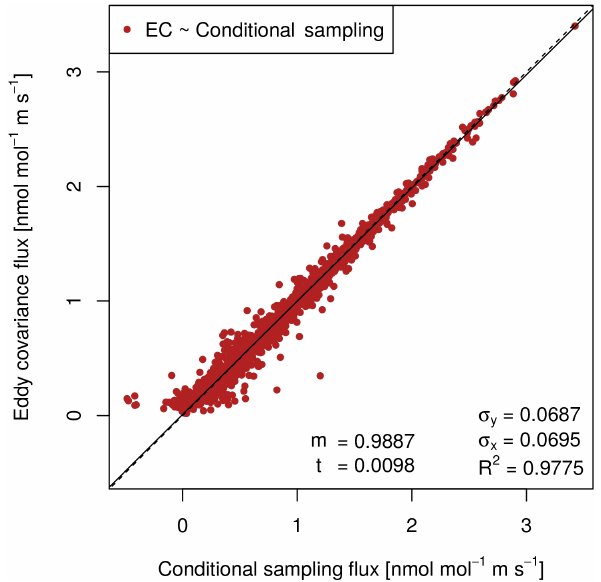
Figure 1. Scatterplot of conditional sampling against eddy covari- ance methane flux for times with best steady-state conditions and well-developed turbulence. The dashed line follows the function f (x) = x and the solid one is the orthogonal regression